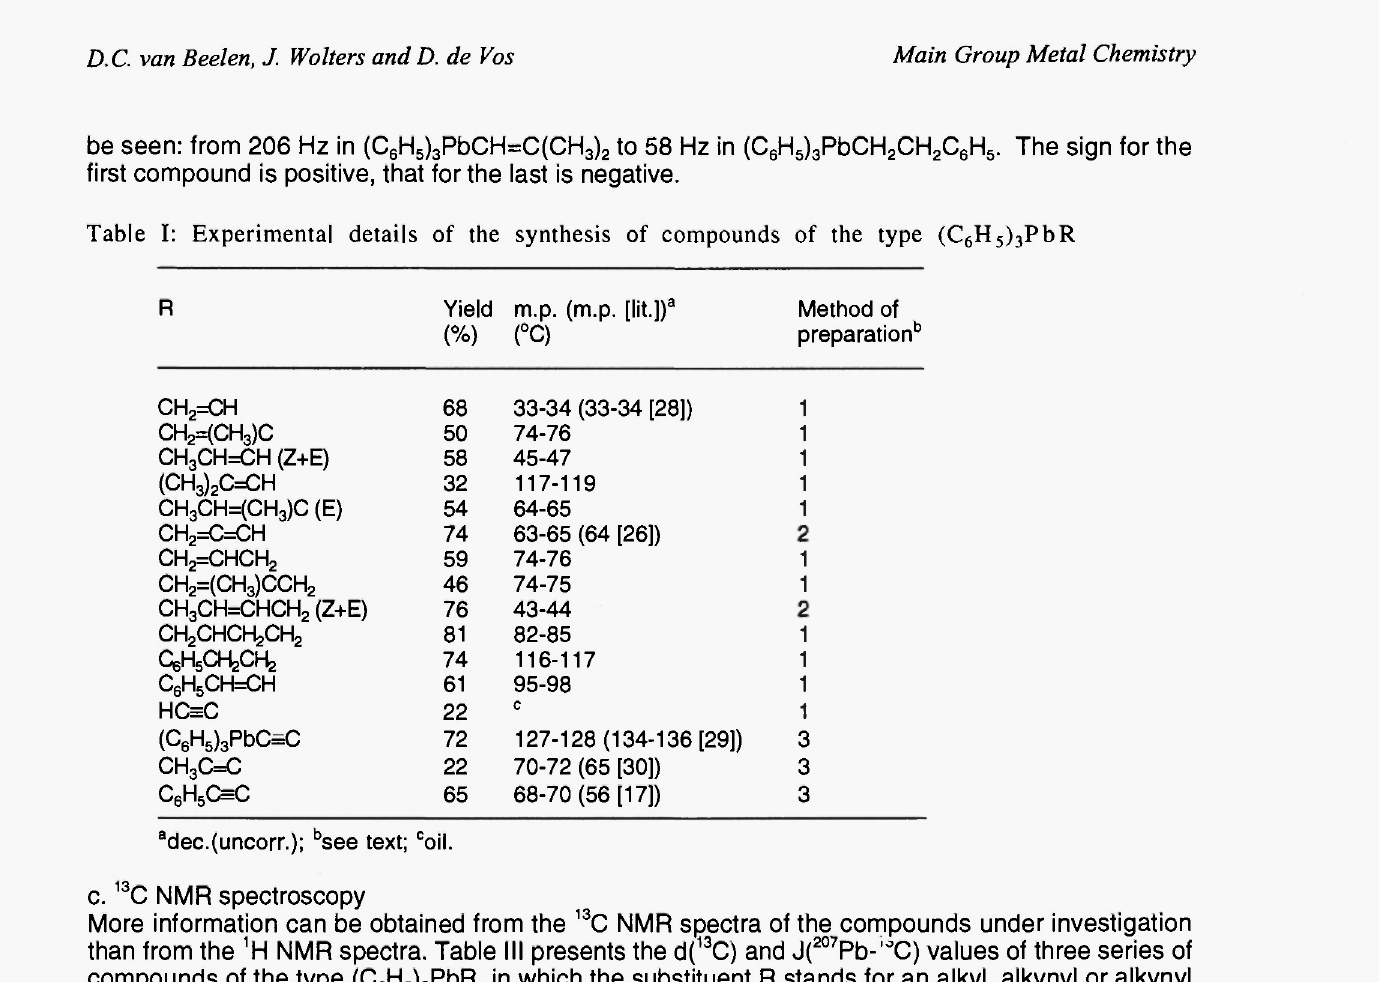
R Yield m.p. (m.p. [lit.]) 3 Method of (%) (°C)